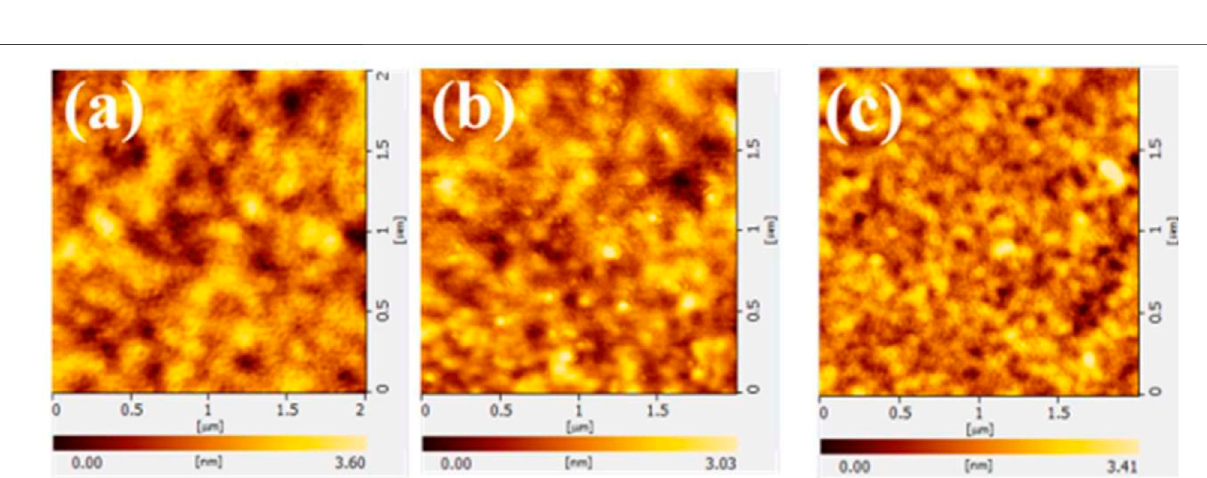
Frontiers in Chemistry |